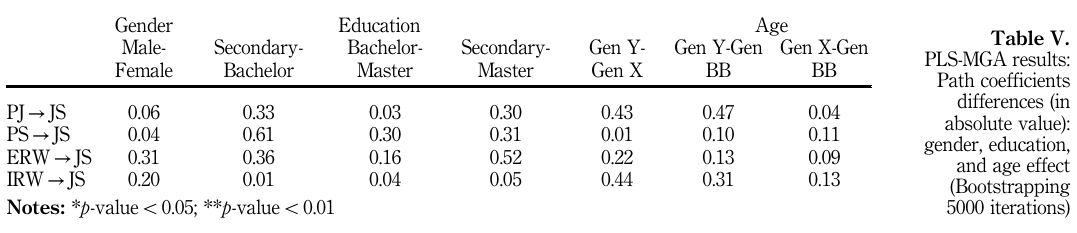
Table V. PLS-MGA